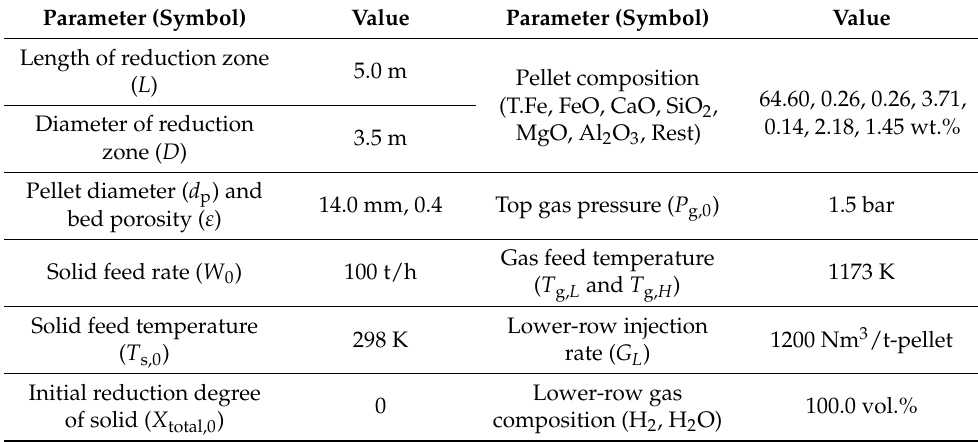
Table 2. Key specifications and model parameters of the H 2 -SF in this work.